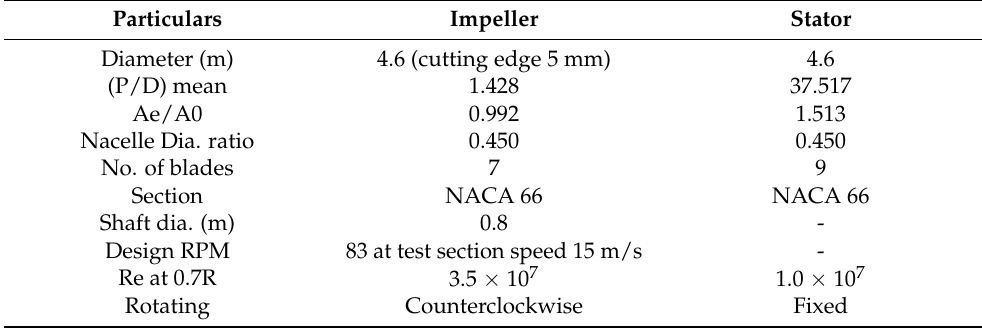
Table 1. Particulars of the axial flow